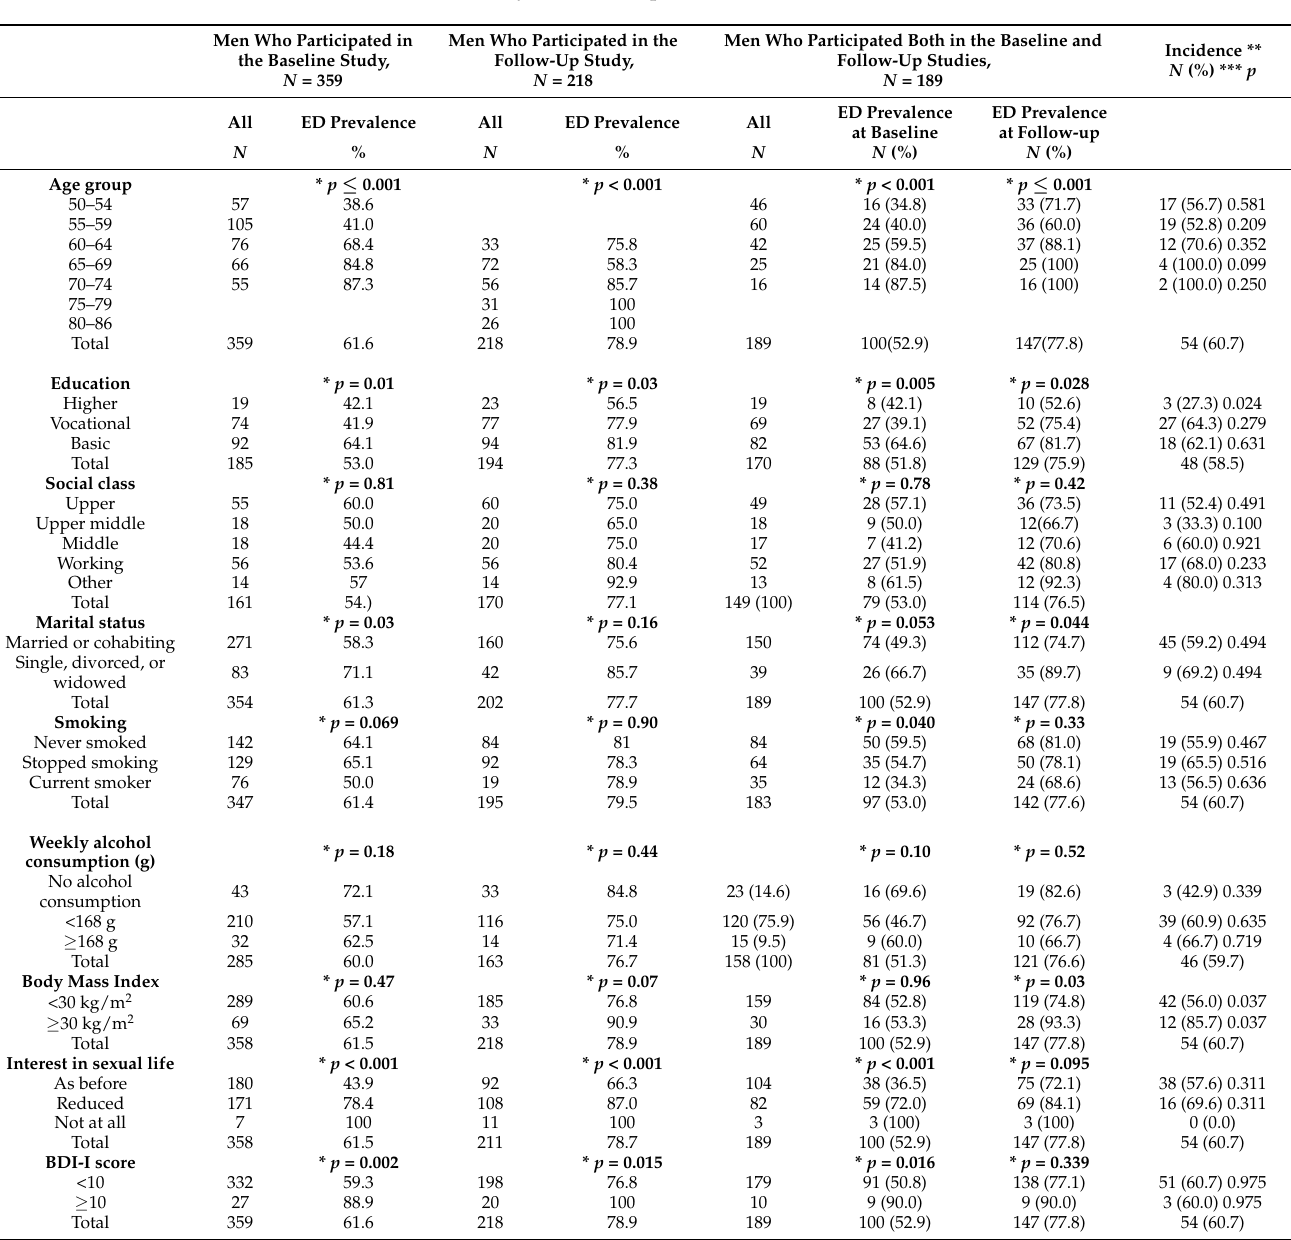
Table 1. Distribution figures for specific socio-demographic and lifestyle variables, along with the frequency and prevalence (%) of erectile dysfunction (ED) in the categories for these variables in the baseline and twelve-year follow-up